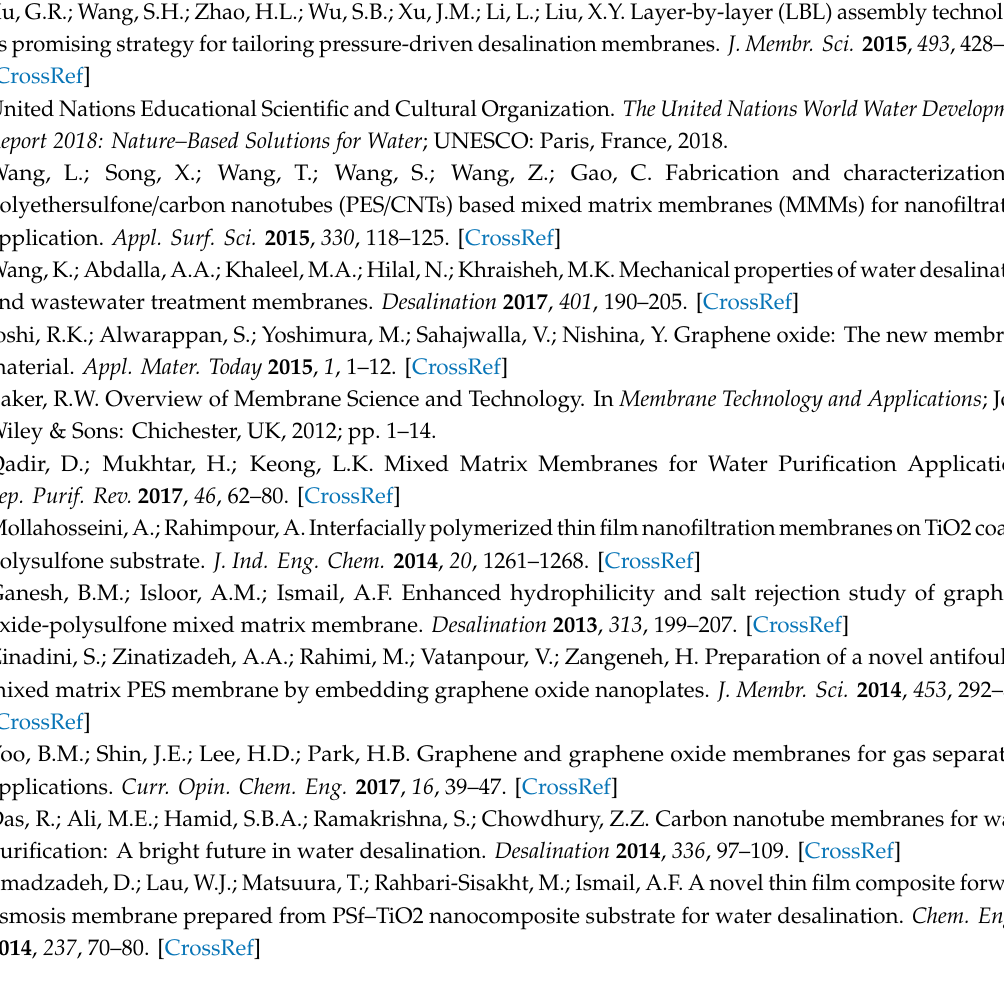
Figure S1: XPS spectra results of GO S , Figure S2: XPS spectra results of GO H , Figure S3: XPS spectra results of GO T , Figure S4: AFM images of membranes at 2 × 2 µ m scan area, Figure S5: SEM images of cross-sections, Figure S6: Stress-strain curves of uniaxial tension